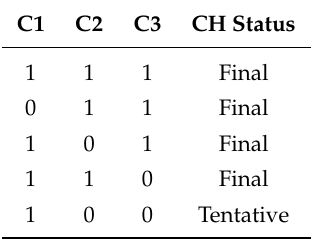
Table 3. CH Self-election